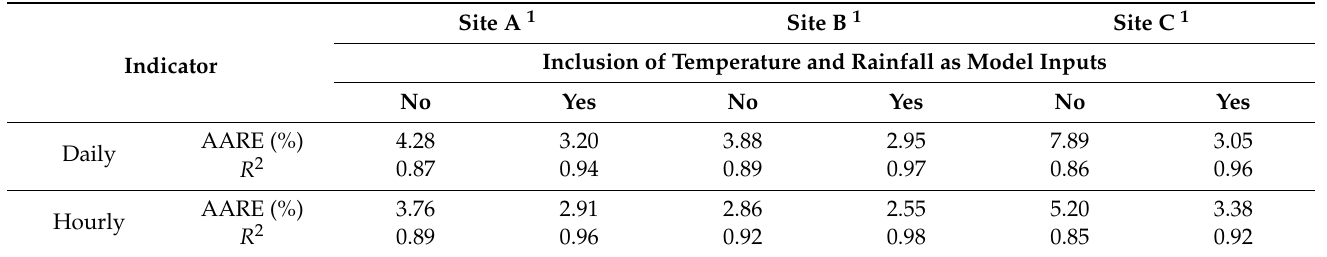
Table 5. Training accuracy of ARMA models in three sites.